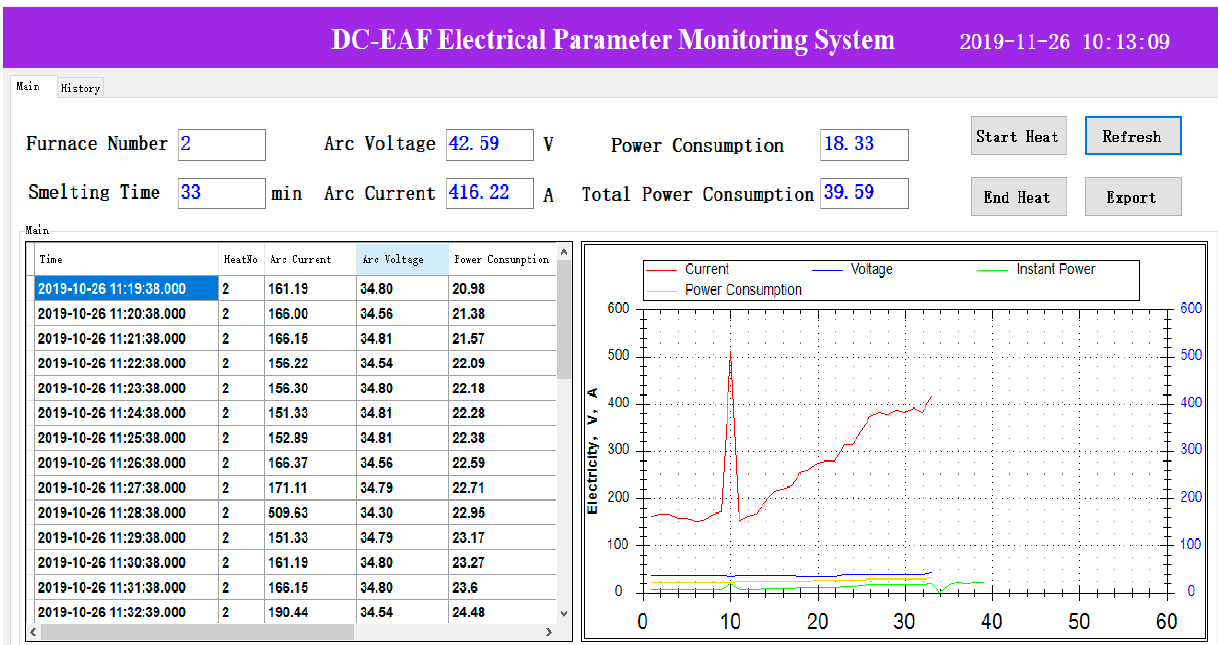
Figure 11. GUI for the process monitoring system.